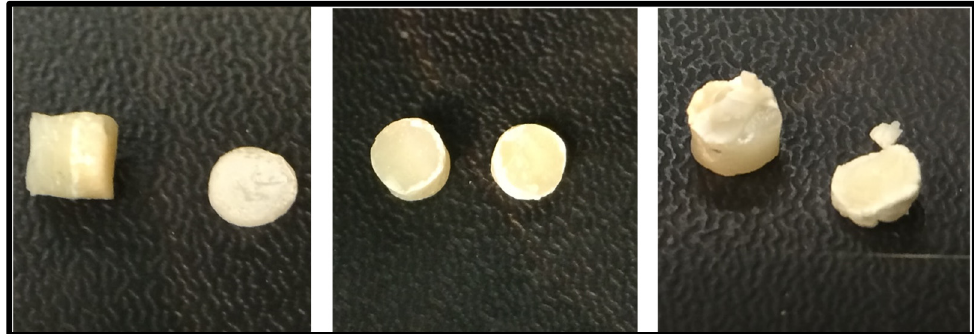
Figure 6. The failure modes after testing: adhesive failure ( left ), cohesive failure ( middle ), and mixed